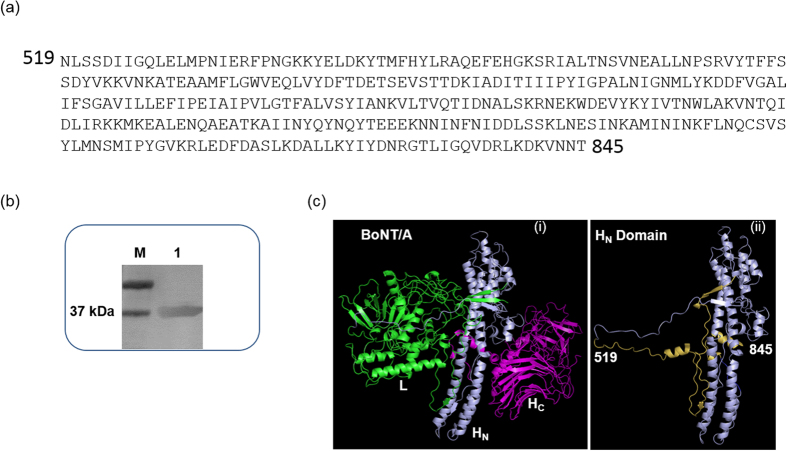
Structural characterization of BoNT/A peptide HN519-845.(a) Amino acid sequence of the recombinant peptide HN519–845 prepared in the present work. The peptide consists partial belt sequence (519–546) along with two α-helical loops containing the full transmembrane region (618–661). (b) SDS-PAGE analysis of purified peptide HN519–845 showed a high yield of purified peptide (>95%) obtained from the inclusion bodies, purified using denaturing conditions. The peptide was refolded using 0.5% (w/v) sodium lauryl sarcosine. Lane M, Bio-Rad Precision Plus ProteinTM Dual Xtra Standard; Lane 1, purified HN519–845. (c) (i) The 3-dimensional structure of whole BoNT/A with individual domains marked (ii) the HN domain of BoNT/A with yellow region showing the part of belt region expressed in HN519–845.